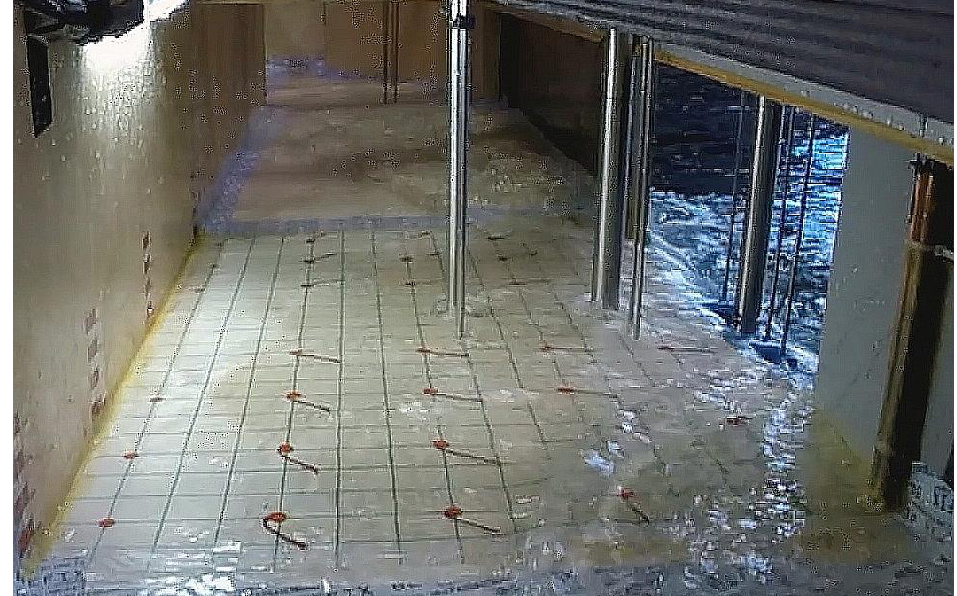
Figure 6. View on the vehicle deck of the ship model (3/3). Floodwater is flowing back out of the damaged opening. The red tufts for flow visualization are pointing again towards the damage opening, as a result of the floodwater flowing out. As the view is given by a ship-fixed camera, the ship heeling angle is not really visible, but can be inferred from the floodwater accumulating towards the starboard side of the deck.